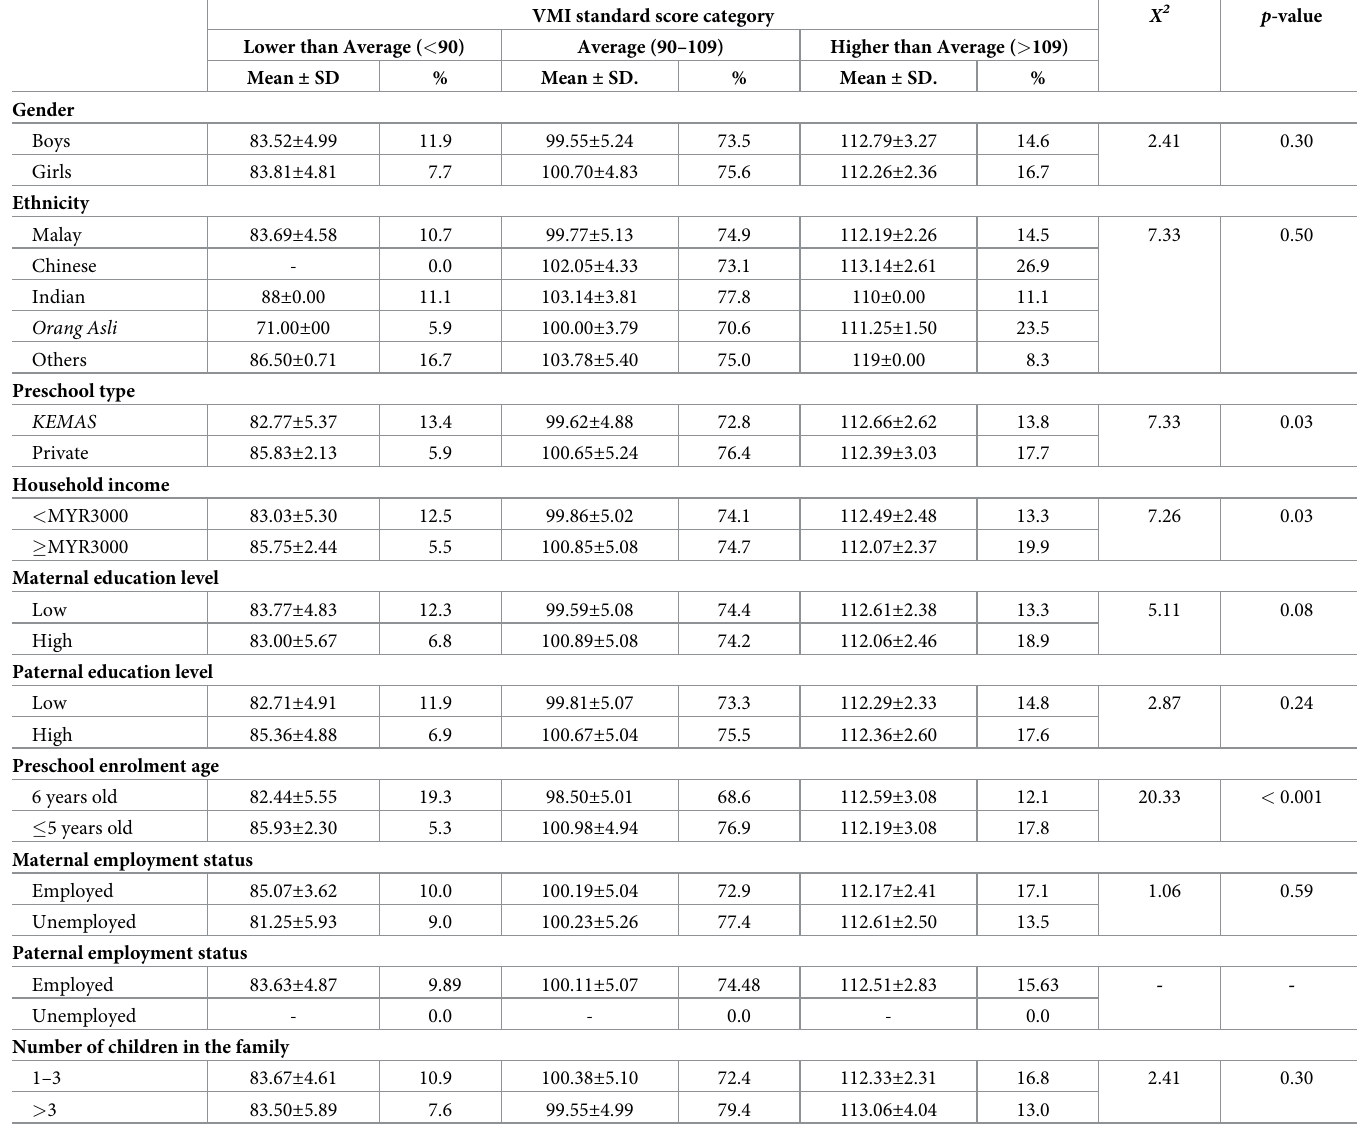
Table 5. Distribution of mean VMI standard scores, percentages, Χ 2 - and p -values by demographic and socioeconomic